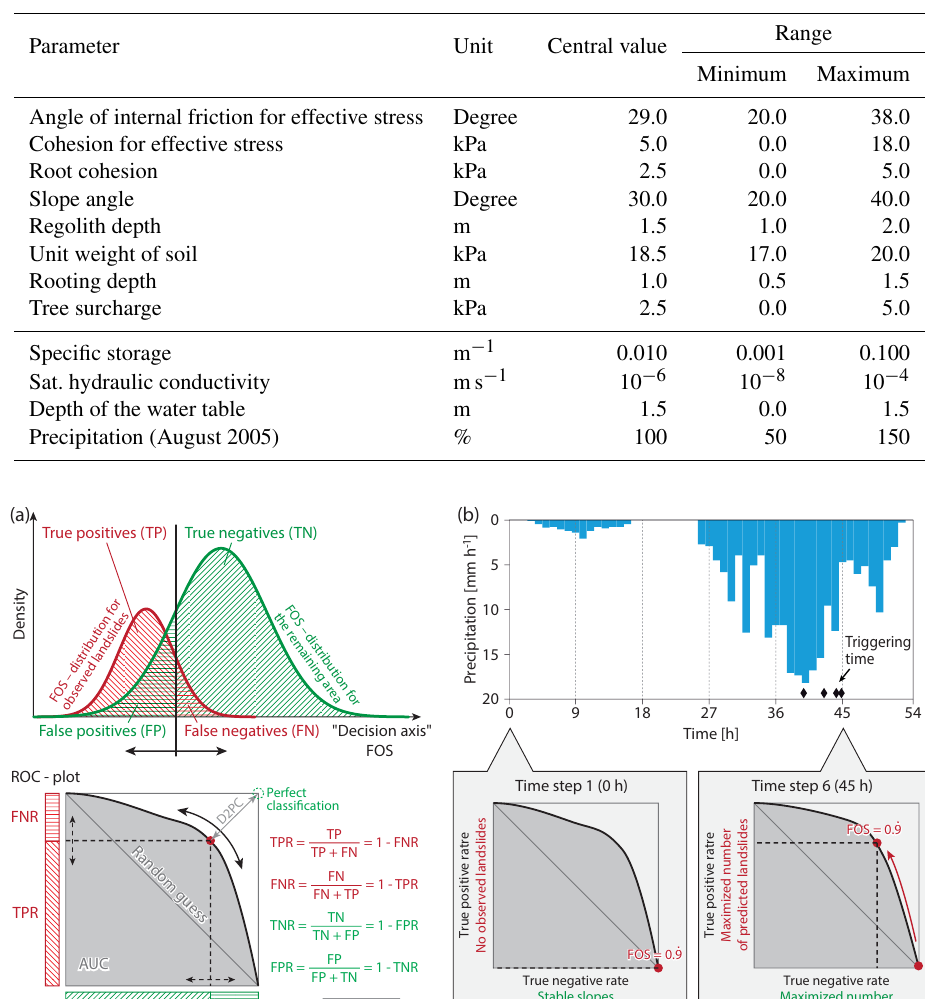
Table 4. Parameter value ranges and central values considered in the OAT sensitivity analyses.